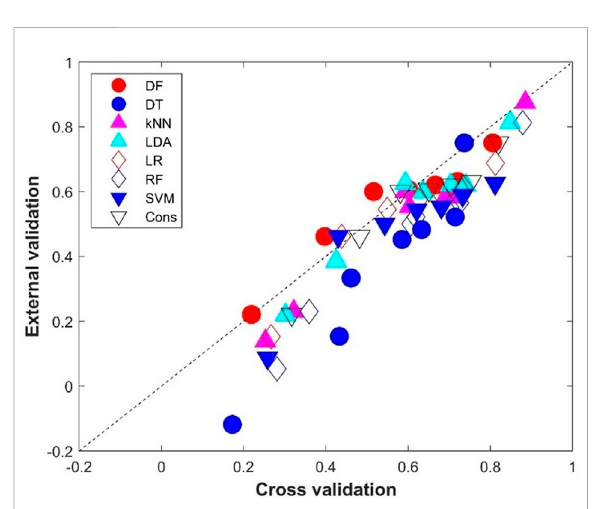
models were calculated by comparing the predictions with the actual rat multigeneration reproductive toxicity study results and were plotted as bars in Figure 6. The overall performance of the external validations showed some predictive power with metrics